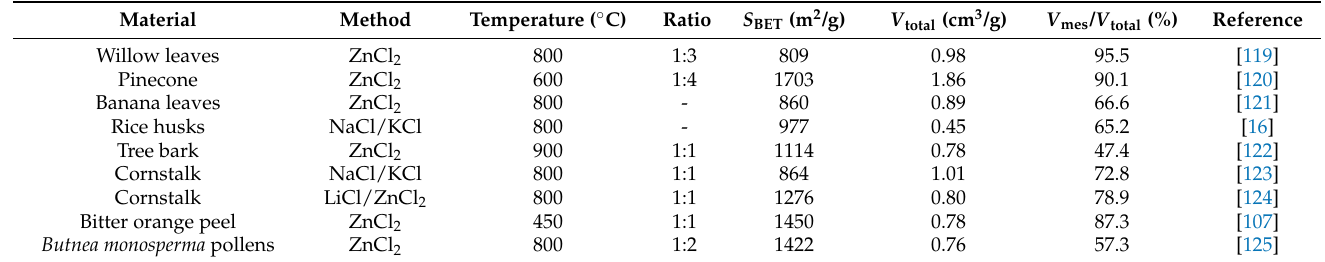
Table 4. Preparation of plant-derived carbon materials by molten salt